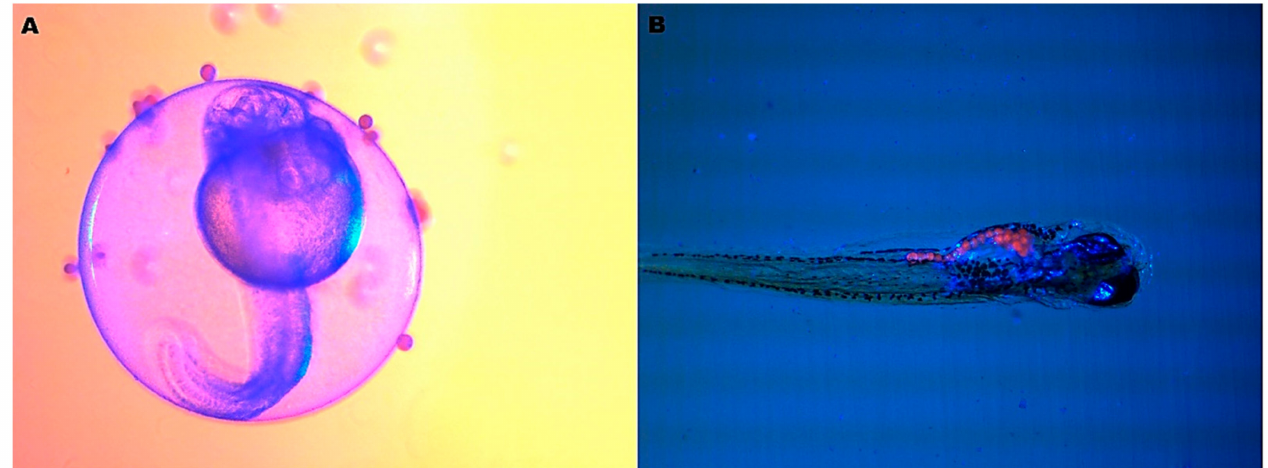
Figure 3. ( A ) Zebrafish embryo 36 hpf exposed at 50 mg.L − 1 , showing plastic microbeads adhered on the outside of the chorionic membrane. ( B ) Microbeads shown in the gut of 7-day-old larva (( A )—25 × and ( B )—15 × magnification, stereomicroscopy